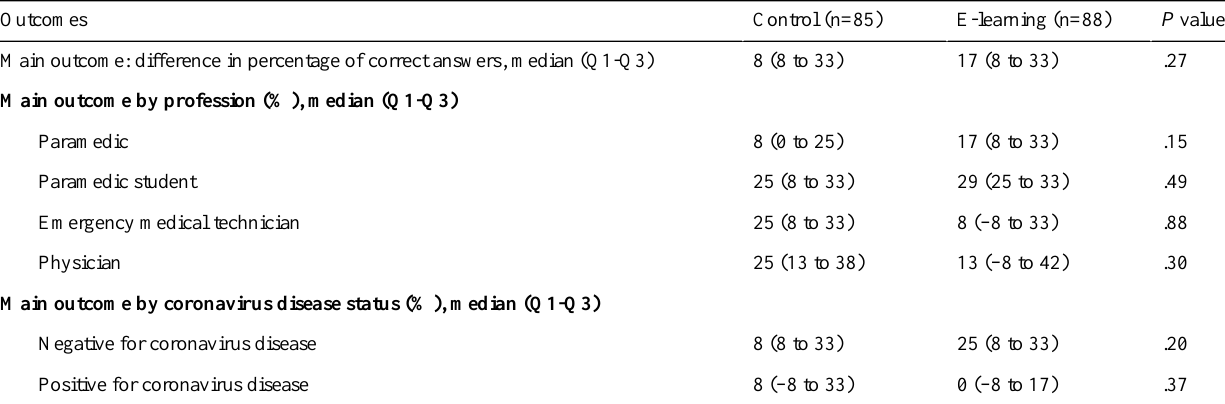
Table 2. Adequate choice of personal protective equipment (main